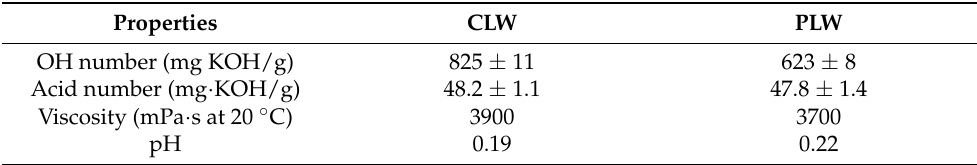
Table 3. Hydroxyl and acid numbers, viscosity, and pH of crude (CLW) and purified liquefied wood